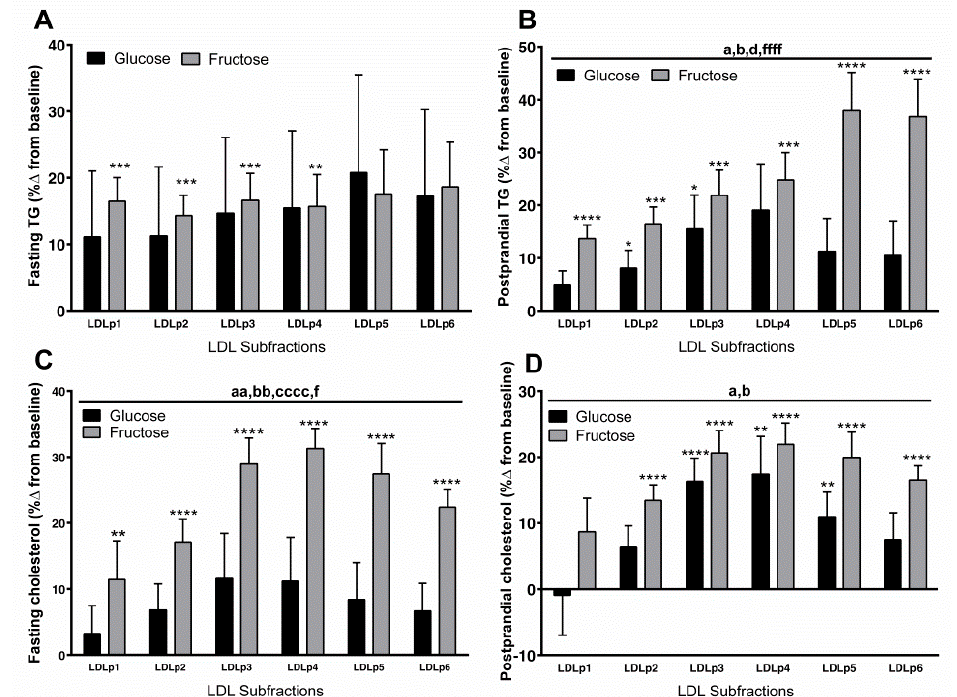
Figure 4. Percent (%) changes (10 weeks vs. 0 weeks) of fasting (A) and postprandial (B) TG and fasting (C) and postprandial (D) chol in LDL subfractions in subjects consuming glucose ‐ sweetened beverages ( n = 15) or fructose ‐ sweetened beverages ( n = 16) for 10 weeks. a p < 0.05, aa p < 0.01, effect of sugar; b p < 0.05, bb p < 0.01, effect of particle size; cccc p < 0.0001, effect of gender, d p < 0.05, effect of sugar × size, f p < 0.05; ffff p < 0.0001 for fructose ‐ induced lineal trend, g p < 0.05 for glucose ‐ induced lineal trend. * p < 0.05, ** p < 0.01, *** p < 0.001, **** p < 0.0001, LS means different from zero—within group change from baseline. Data shown as mean ± SEM. Note the differences in scales.